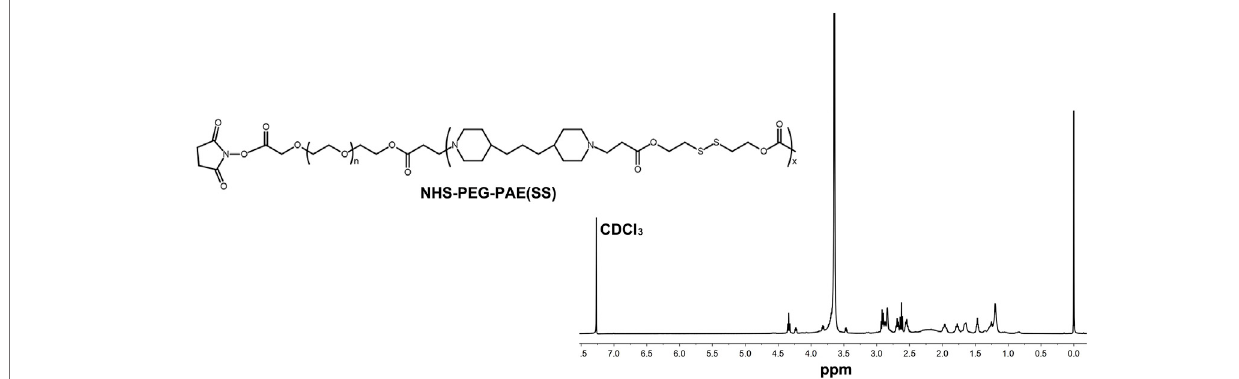
FIGURE 2 | 1 H NMR spectra of NHS-PEG-PAE(SS).